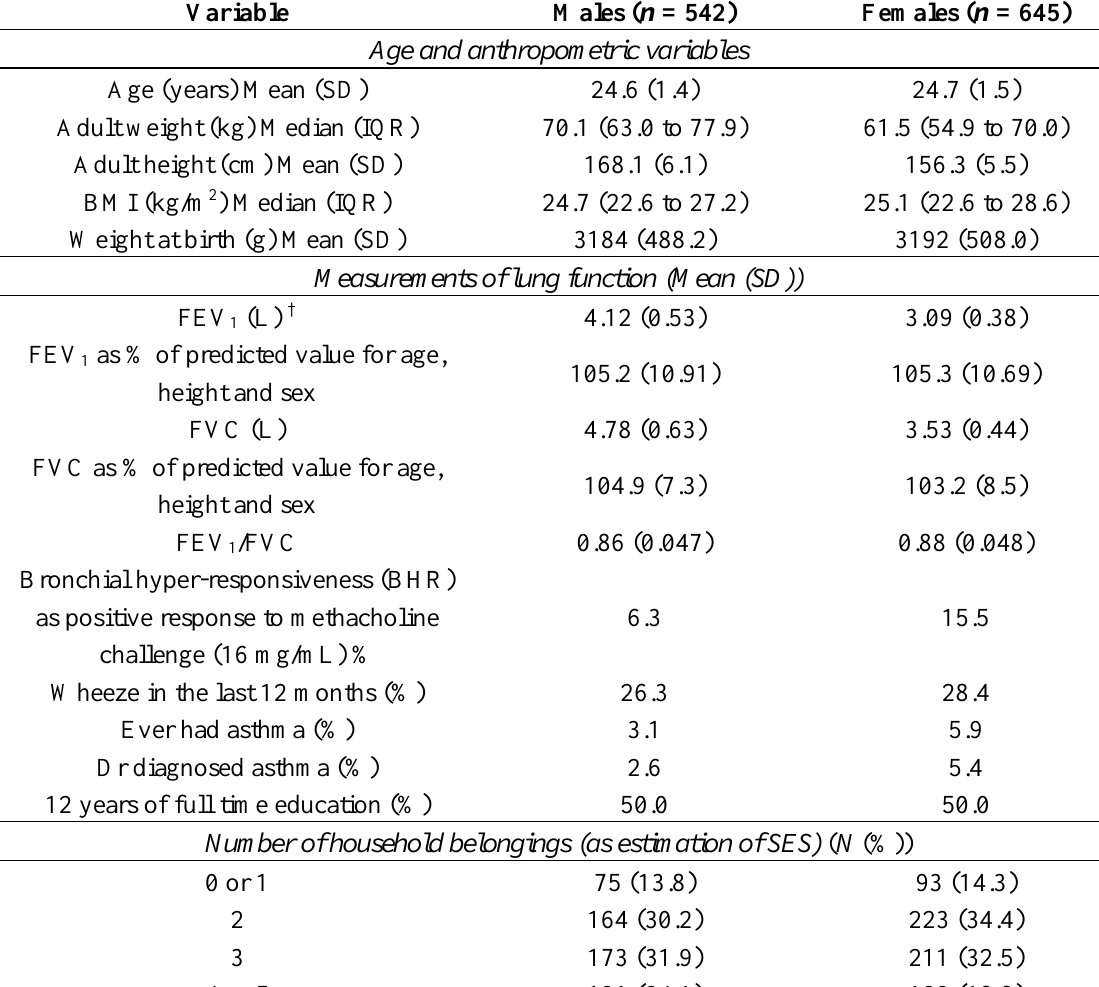
Table 1. General and respiratory characteristics of